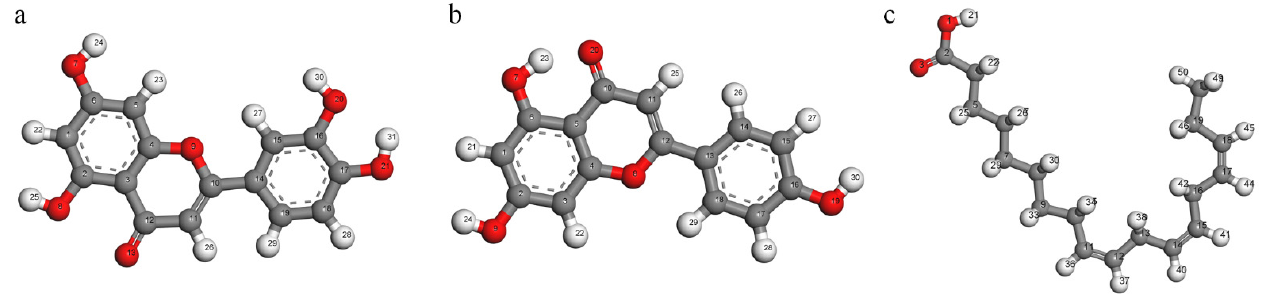
Table 2. Chemical calculation results of corrosion inhibitor components.